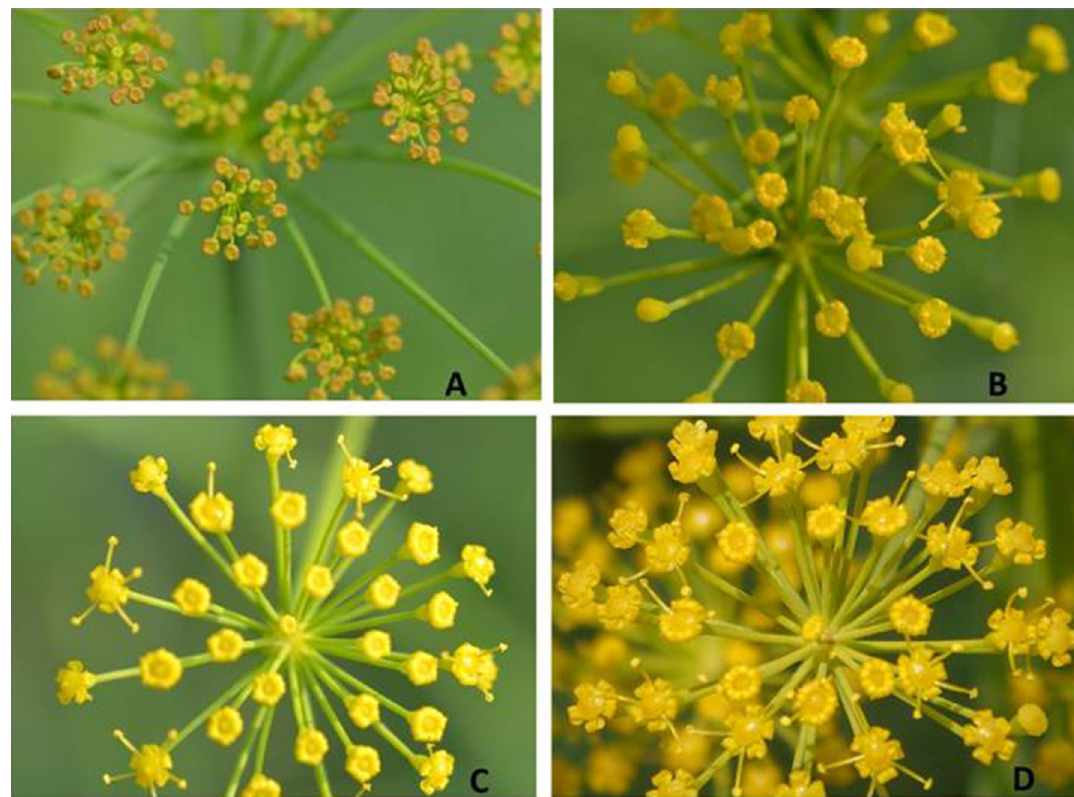
Figure 2. Flower biology of dill seeds ( A flower bud stage; B flower bud opening stage; C partially opened flower, D fully opened